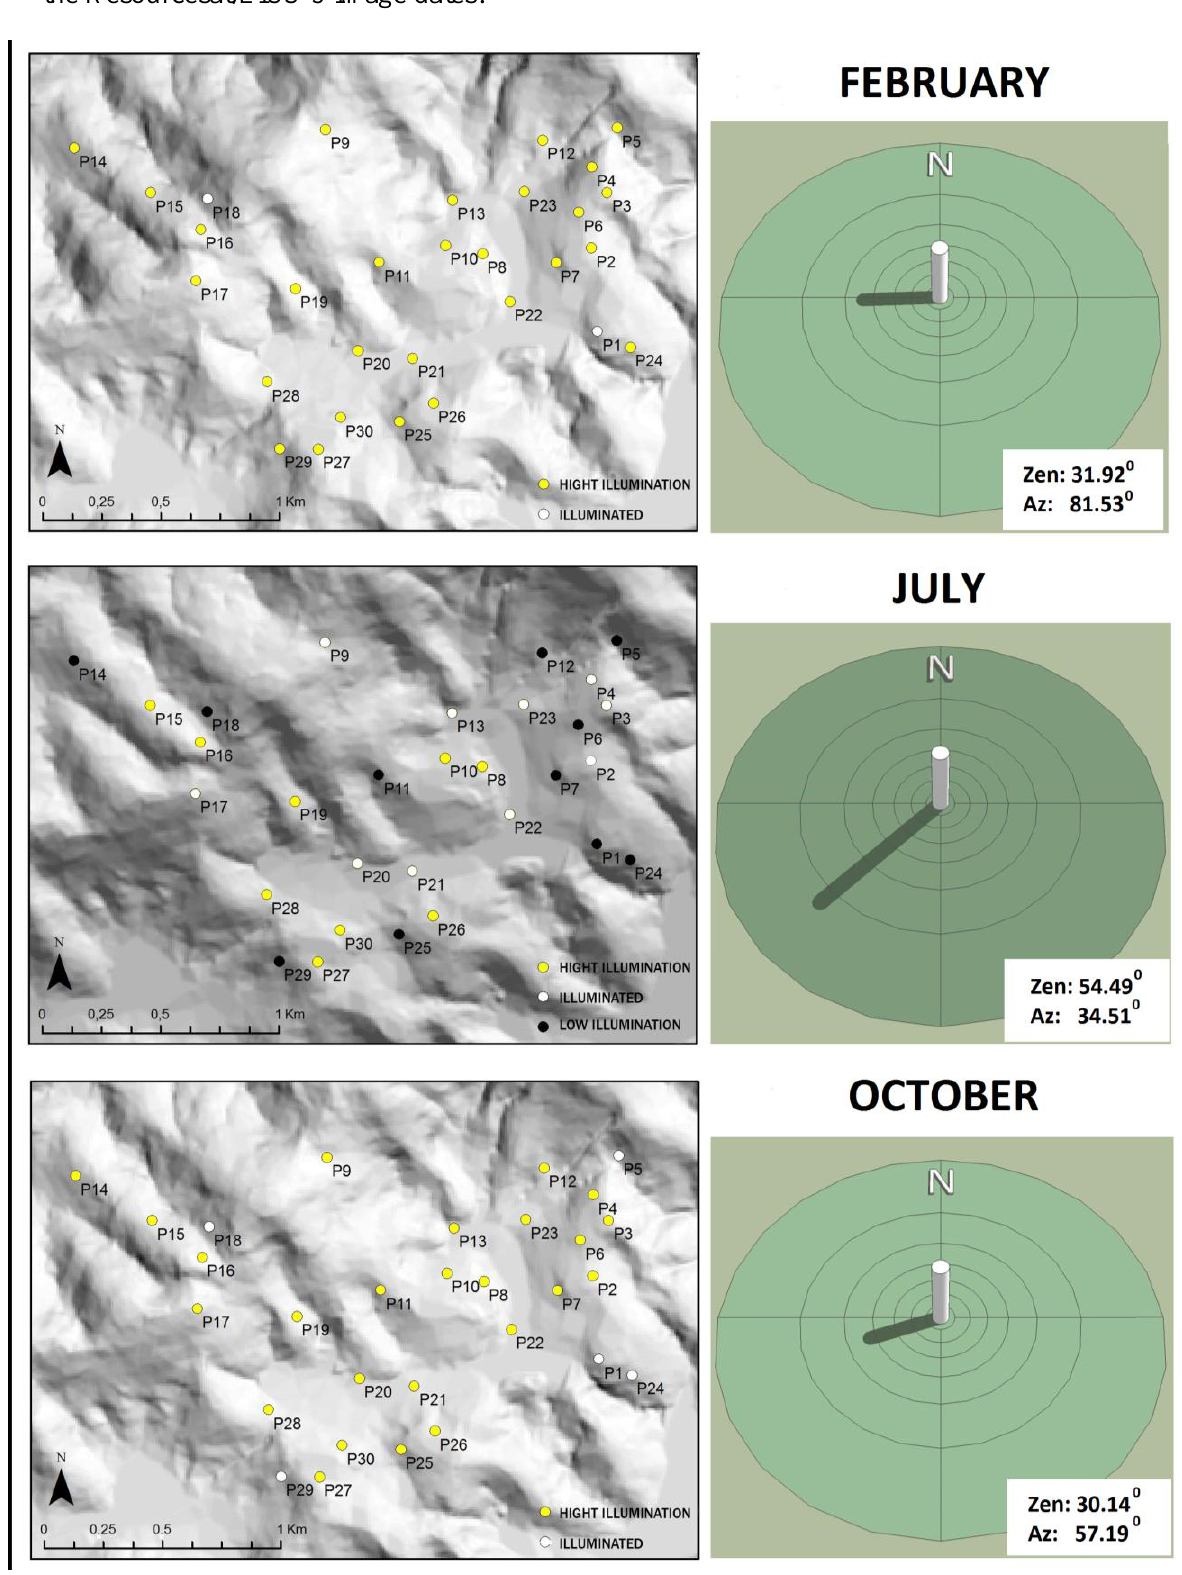
Figure 2. Sample points’ positioning in the study area and the illumination simulation for the Resourcesat/LISS-3 image